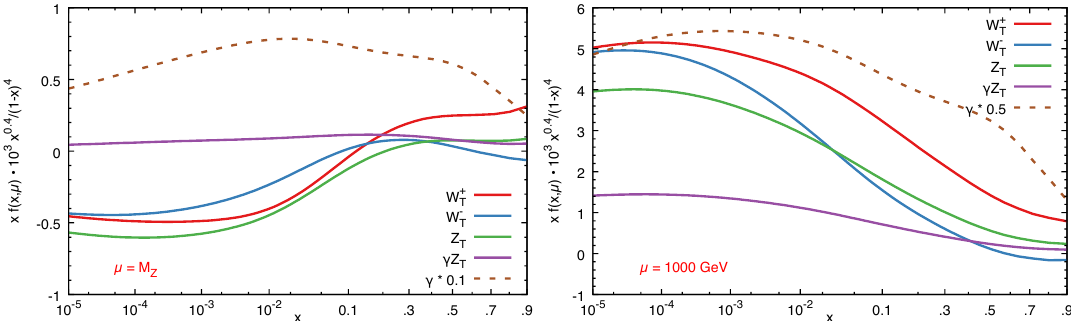
Figure 5 . The transverse gauge boson PDFs f for (cid:22) = M Z and (cid:22) = 1000 GeV. The unpolarized photon PDF (dashed, brown) has also been shown for comparison, multipled by 0 : 1 at (cid:22) = M Z and by 0 : 5 at (cid:22) = 1000 GeV, so it (cid:12)ts on the same plot. (cid:24) m 2 =M 2 (cid:24) 10 (cid:0) 4 , the size of low-energy weak interaction corrections and smaller p W